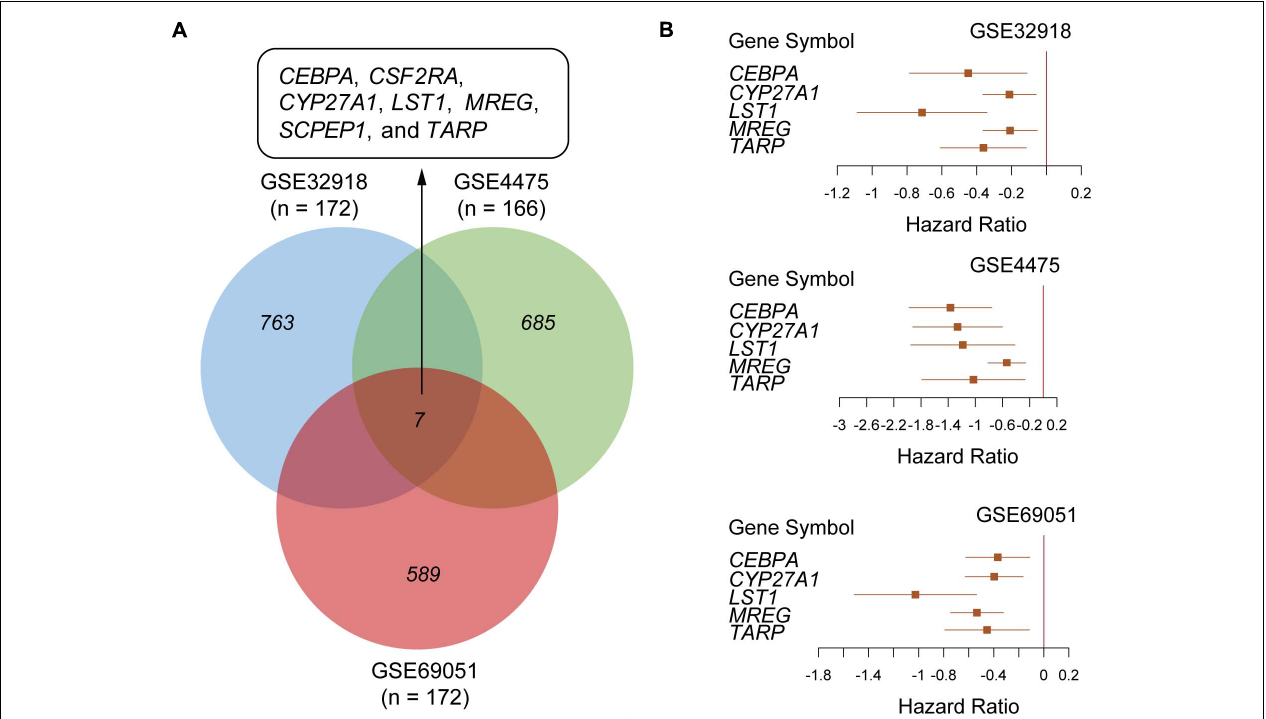
FIGURE 1 | Screening a five-gene Cox model in the public DLBCL datasets from Gene Expression Omnibus (GEO). (A) Venn diagram summarizing the overlap between the prognostic genes identified by univariable Cox regression analysis in three public DLBCL datasets with accession numbers of GSE32918 ( n = 172), GSE4475 ( n = 166) and GSE69051 ( n = 172). (B) The forest plots represent the association of the five gene signatures with overall survival in the three public DLBCL datasets.